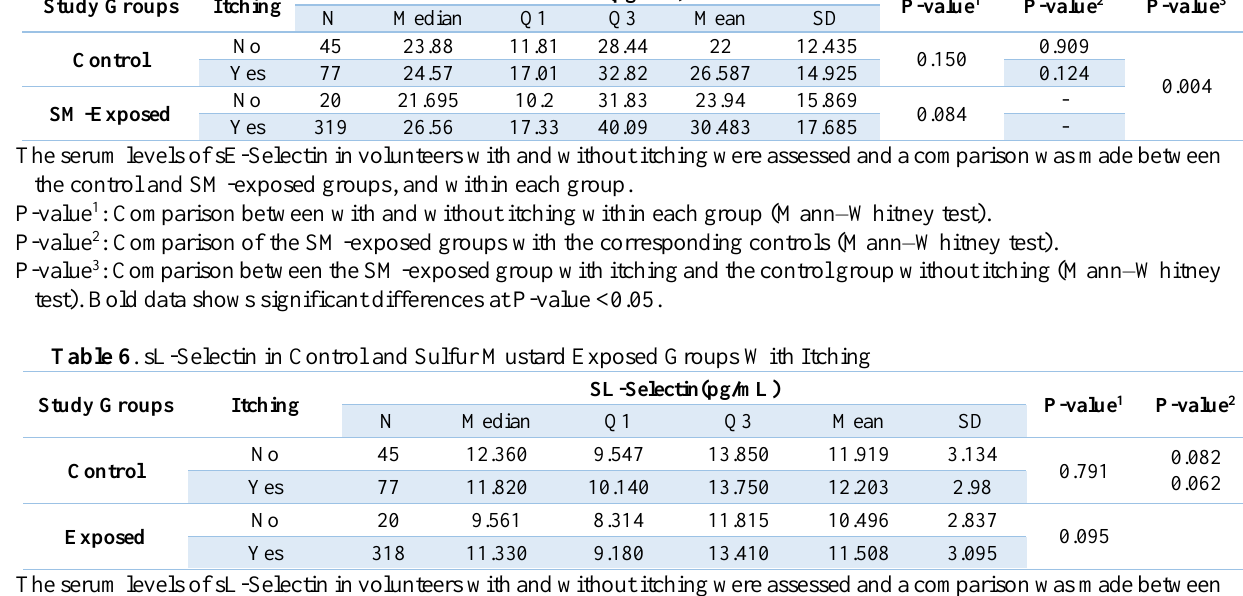
SE-Selectin (pg/mL)